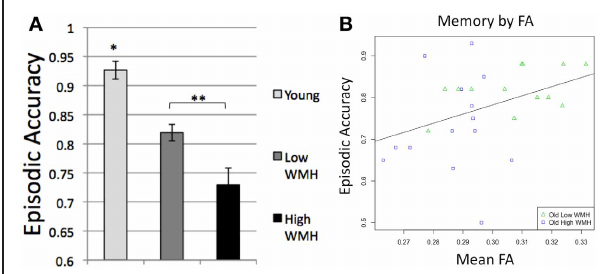
FIGURE 3 | (A) Episodic accuracy by group, ∗ Differs from all groups, p < 0 . 0001, ∗∗ Groups differ, p = 0.012; (B) Episodic accuracy by mean global white matter FA.